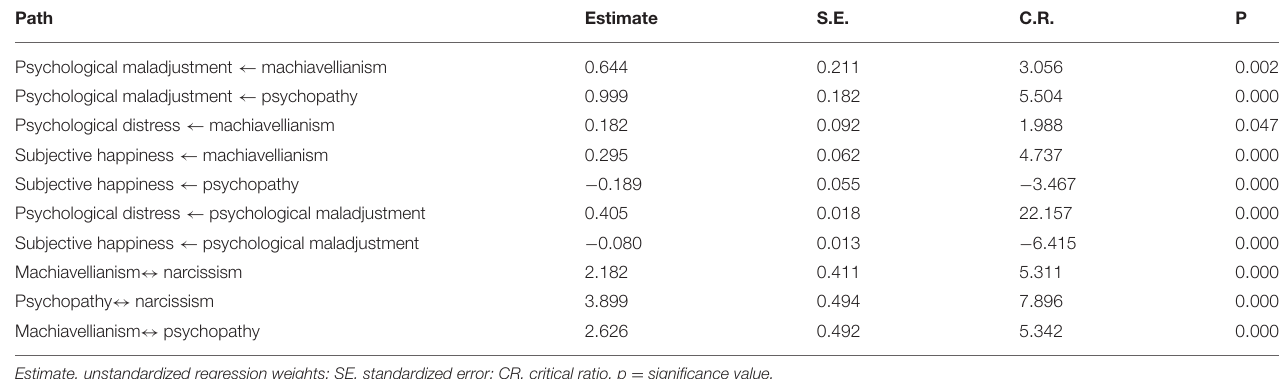
TABLE 6 | Structural equation model path coefficients.